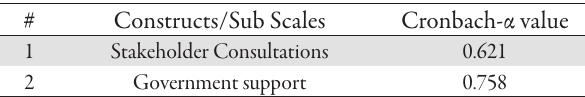
Tab. 1. Reliability Coefficient scores (Cronbach’s alpha